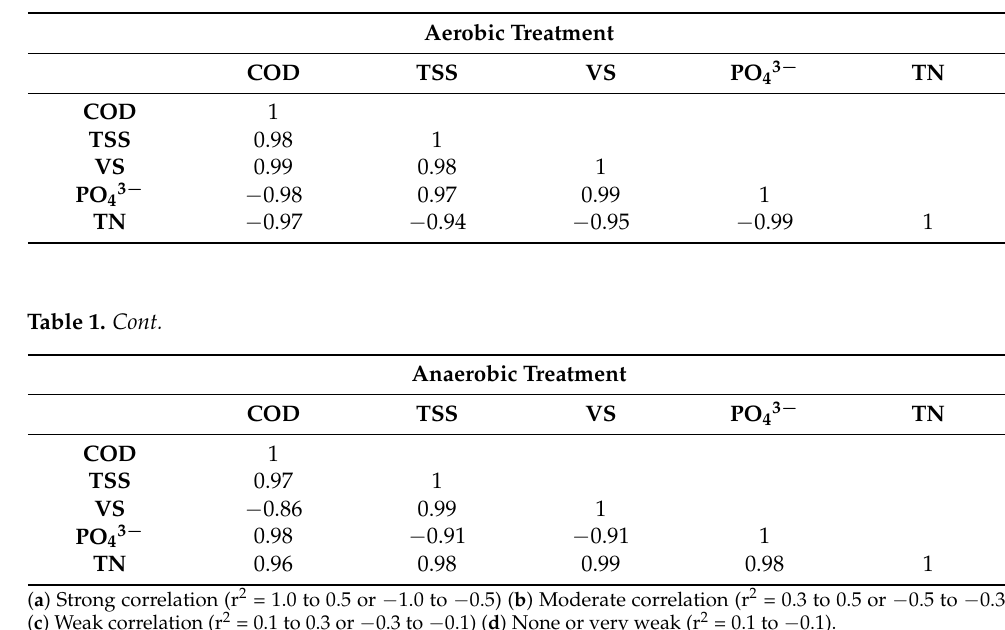
Table 1. Correlation matrixes of the different parameters at aerobic and anaerobic treatment.